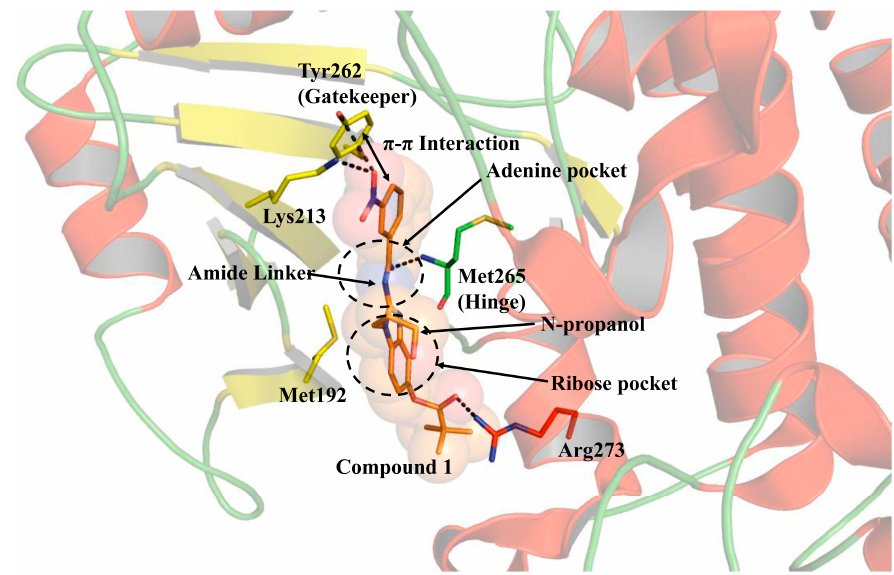
Figure 4. Interaction of compound 1 (2NRU) with the catalytic site of IRAK4 kinase domain. Compound 1 ( N -acyl 2-aminobenzimidazole) displays three kinase-specific interactions: a π - π interaction with the gatekeeper Tyr262, an H-bond with the backbone of hinge Met265, and an H-bond with the catalytic Lys213. Compound 1 perfectly occupies the ATP binding site with the amide linker positioned at the ATP-adenine pocket and the N-propanol substitution positioned at the ATP-ribose binding area.